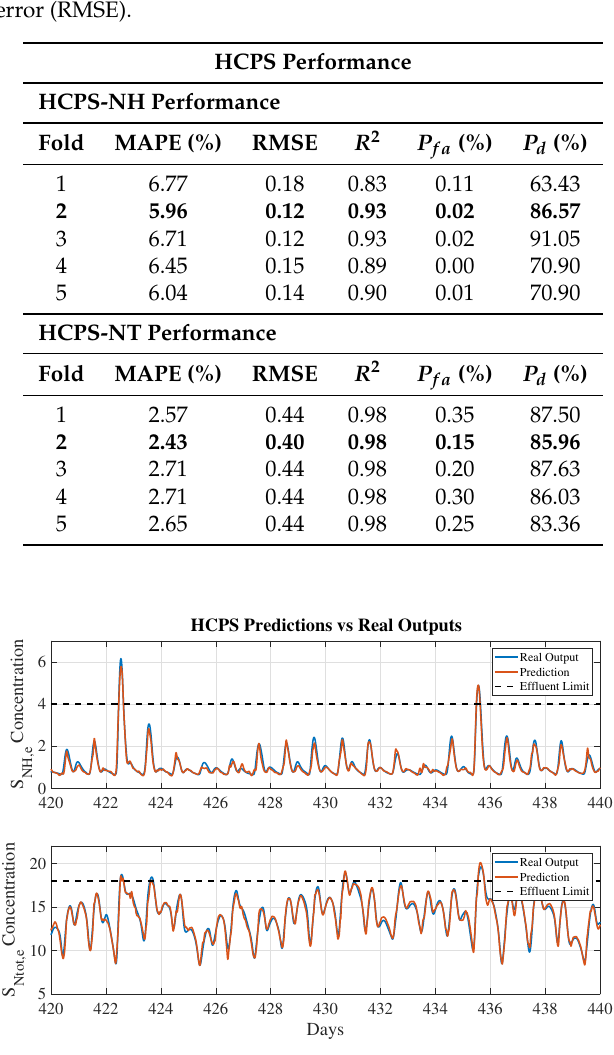
Figure 10. HCPS predictions vs. real